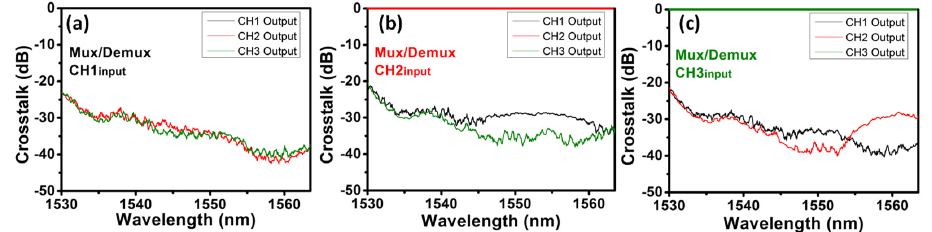
Figure 5. Measured normalized mode crosstalk of ( a ) MDM CH1, ( b ) MDM CH2 and ( c ) MDM CH3.